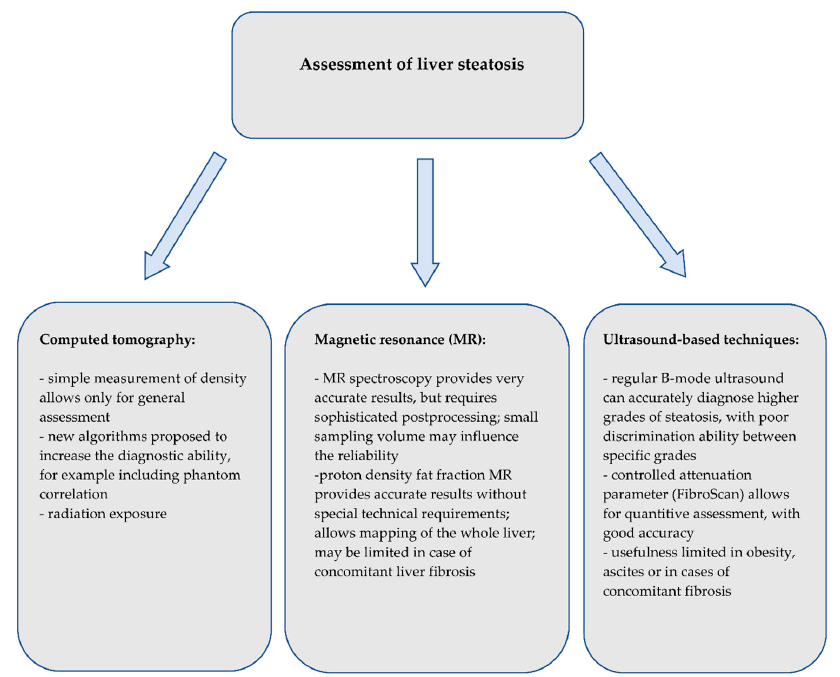
Figure 8. Summary of the imaging techniques for the assessment of liver steatosis.